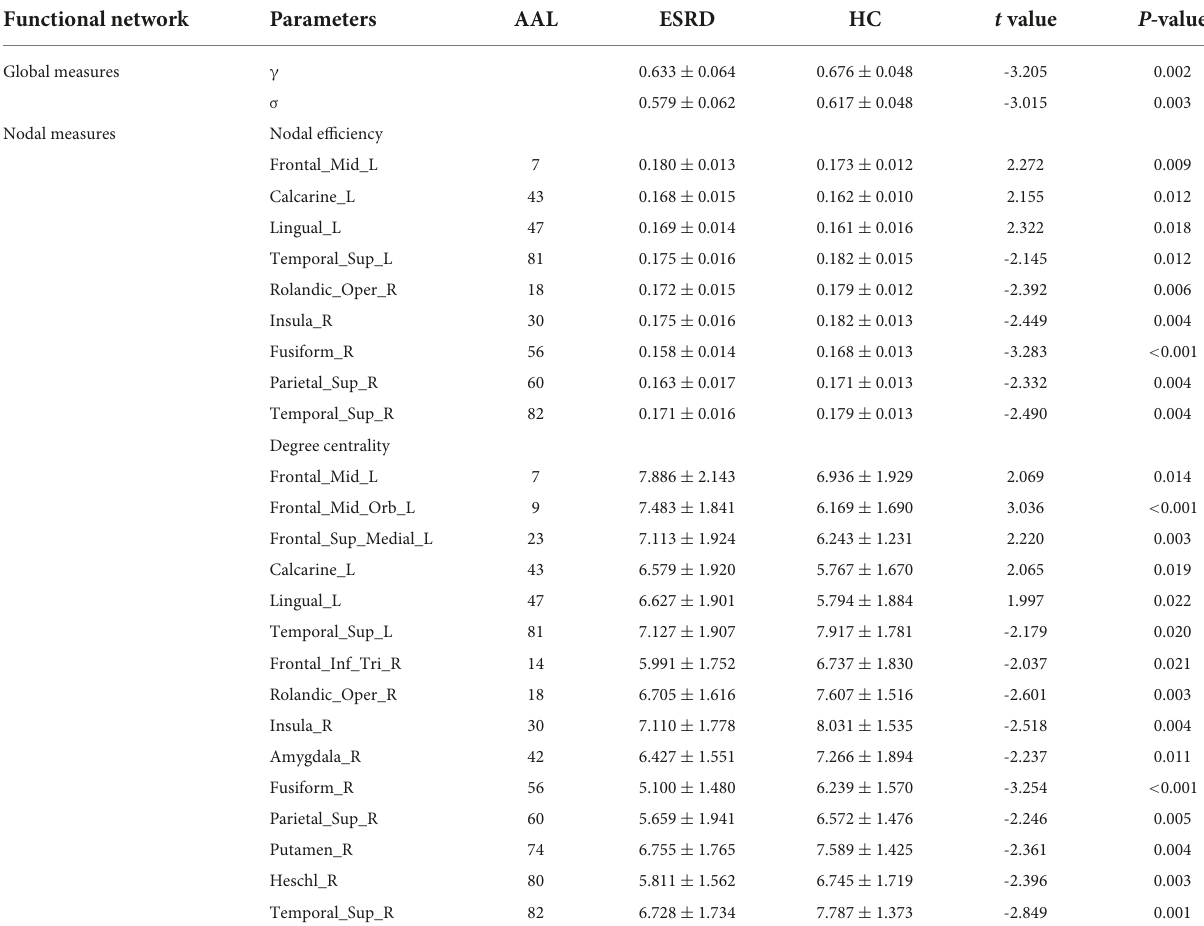
TABLE 3 Significant between-group differences of topological parameters of functional networks. Functional network